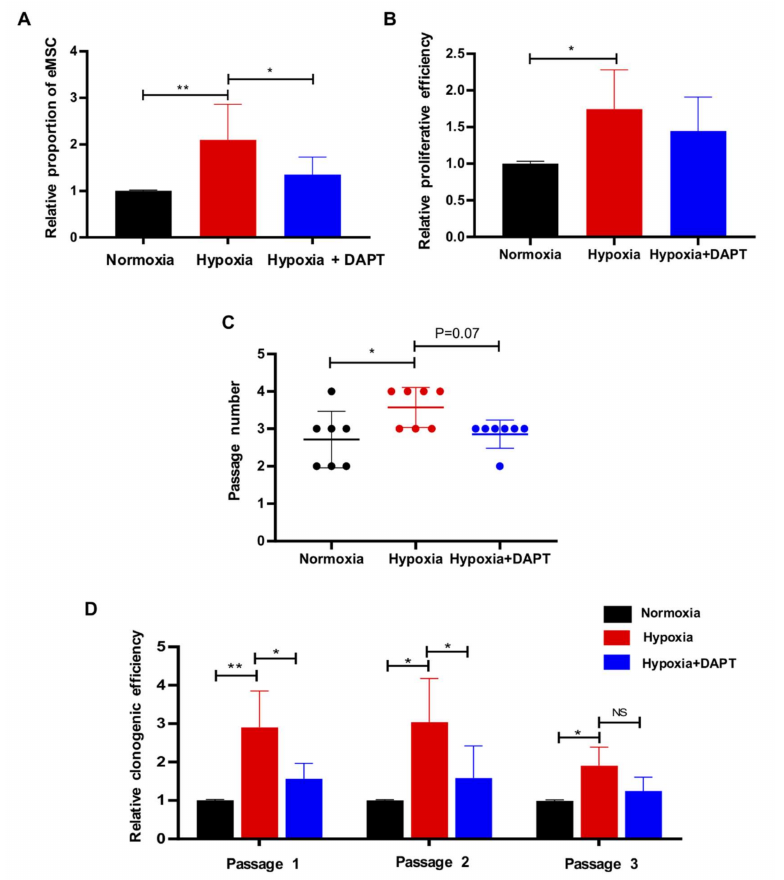
Figure 5. Hypoxia requires Notch signaling to drive the maintenance of eMSC. ( A ) Relative per- centage of CD140b + CD146 + cells cultured under different conditions by flow cytometry ( n = 6). ( B ) Relative proliferative ability of eMSC cultured under different conditions ( n = 6). ( C ) The self- renewal activity of eMSC cultured under different conditions ( n = 7). ( D ) Relative clonogenic efficiency of eMSC cultured under different conditions at different passages ( n = 4–6). Results are presented as mean ± SD; * p < 0.05; ** p < 0.01. Abbreviation: eMSC, endometrial mesenchymal stem-like